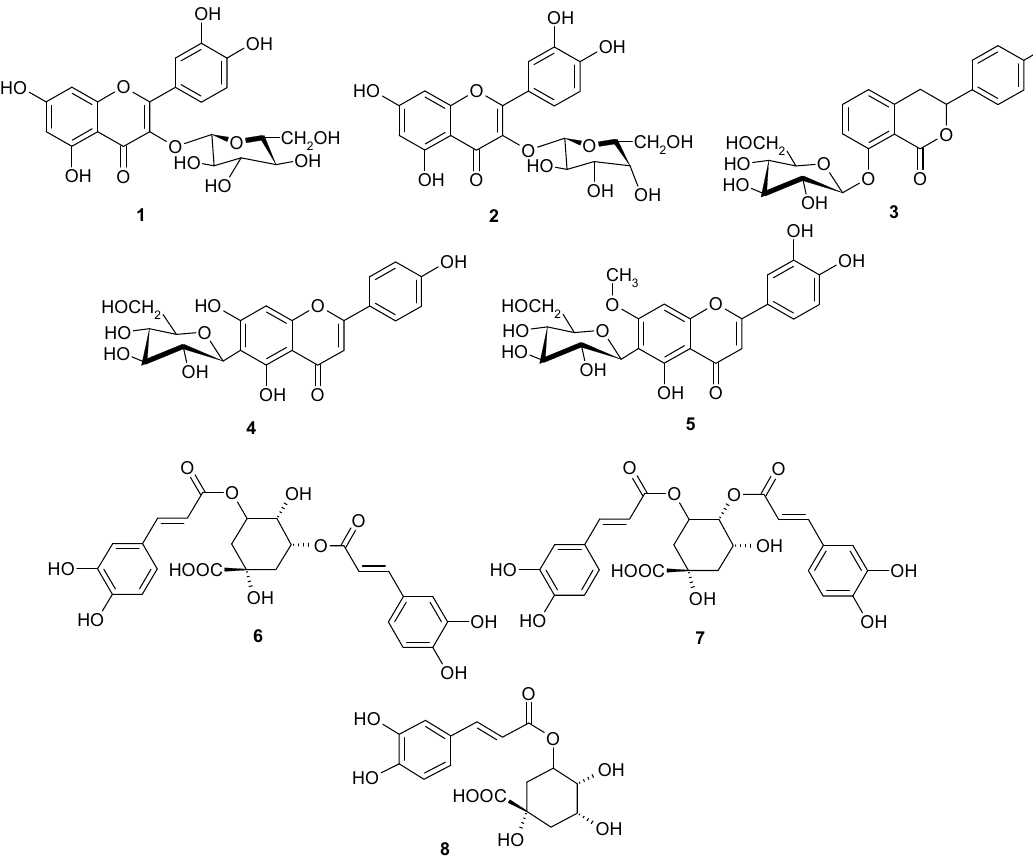
Figure 5. Phenolic constituents of Scorzonera species found in Scorzonera extracts and tested for TNF- α production inhibition.